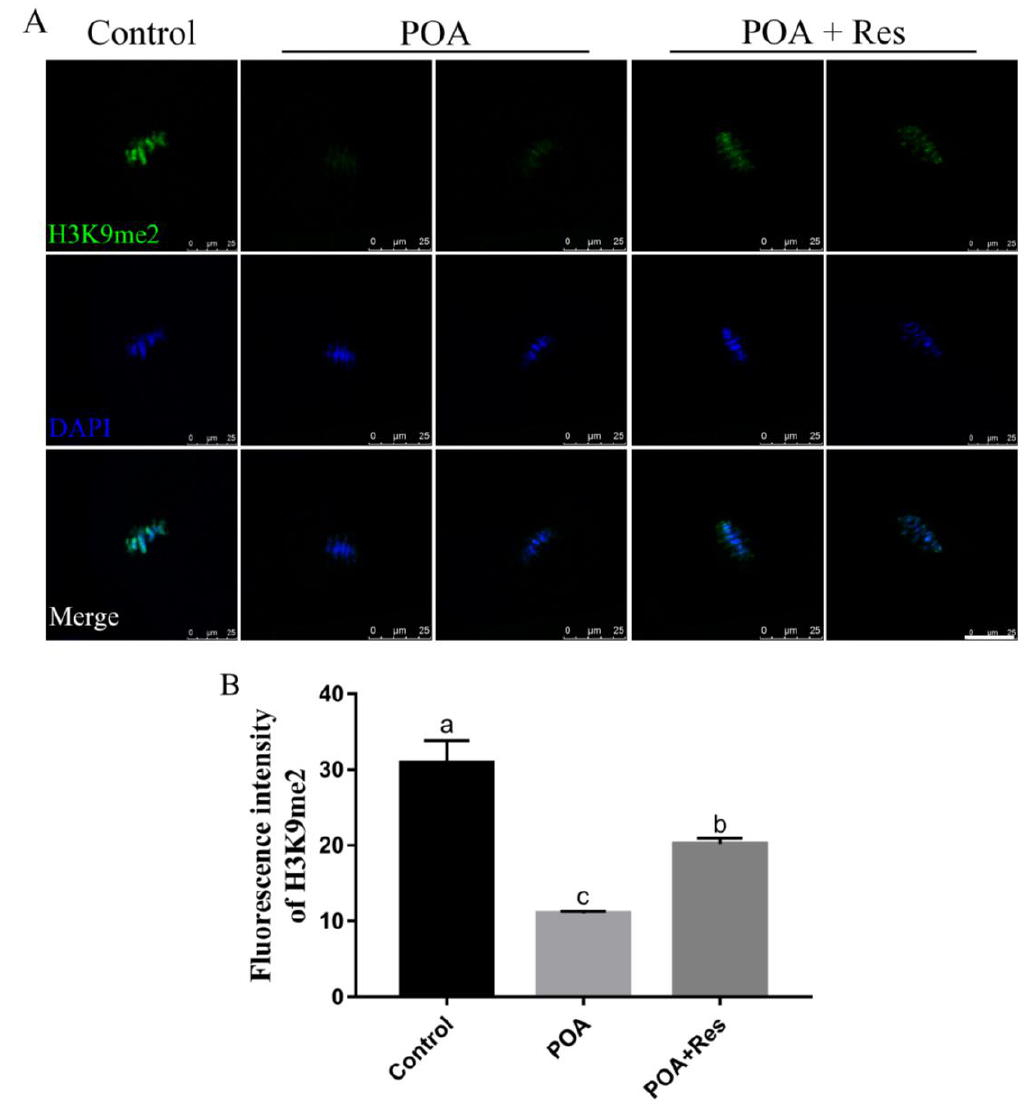
Figure 8. Protective e ff ects of resveratrol on the level of H3K9me2 in POA oocytes. ( A ) Representative images of H3H9me2 (green) in the control, POA and resveratrol-treated POA (POA + Res) oocytes. Scale bar = 25 µ m. ( B ) The fluorescence intensities of H3H9me2 in the control, POA and POA + Res groups. Data are presented as mean ± SEM from at least three independent experiments. a–c means not sharing a common superscript is di ff erent; P <